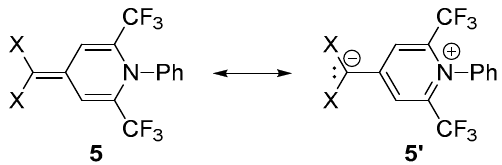
Figure 2. Resonance forms of compound 5 .